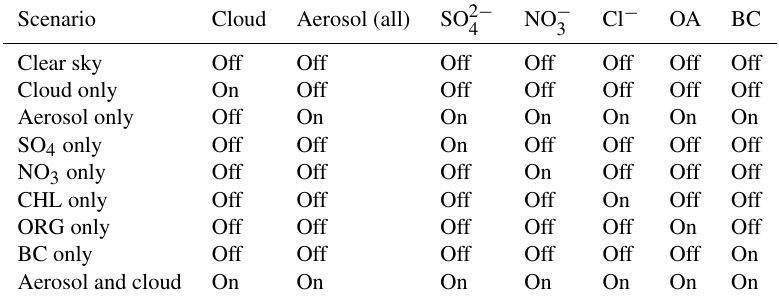
Table 1. Model scenarios run during both campaign periods indicating whether the radiative effects of each aerosol species or cloud is turned on in the respective